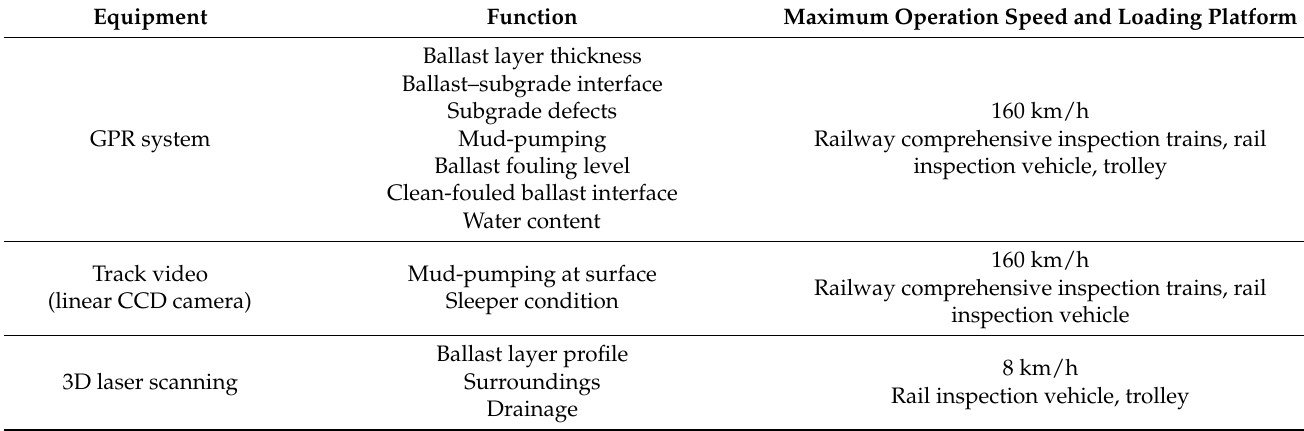
Table 2. Track inspection equipment system configuration, function, and recommended loading